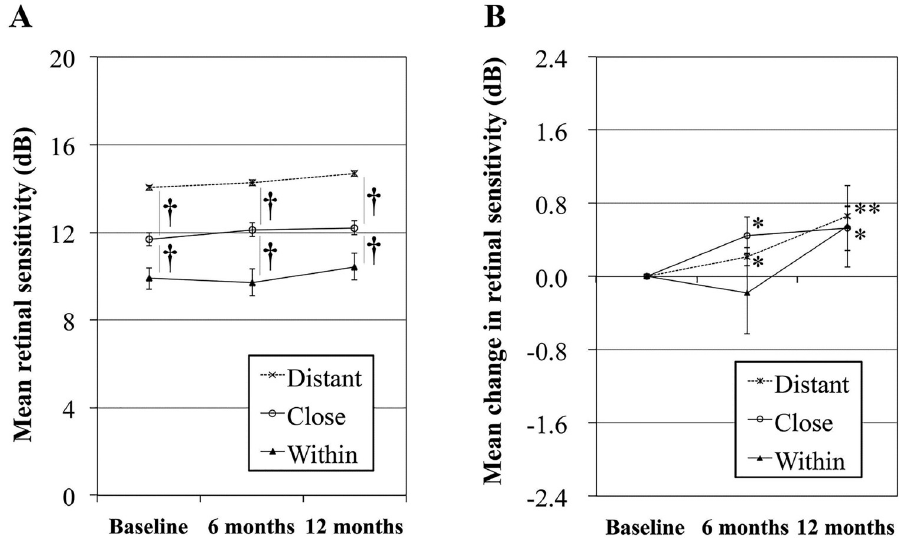
Fig 3. The relationship between retinal sensitivity and the distance from the abnormal FAF. (A) The temporal changes in the mean retinal sensitivity in three groups. (†P < 0.01 vs. close at each time point, ANOVA). (B) The changes in the mean retinal sensitivity from baseline in the three groups. The data are expressed as the mean ± standard error of the mean. ( � P < 0.05 and �� P < 0.01 as compared with baseline, paired t-test). https://doi.org/10.1371/journal.pone.0213161.g003 Table 3. Results of the random intercept and slope model. Parameter Estimate SE P value Distance Within Reference Close 1.18 0.36 0.001 Distant 2.65 0.33 < 0.001 Time 0.05 0.02 0.031 Test point location (degrees) 0.29 0.04 < 0.001 SE, standard error of the